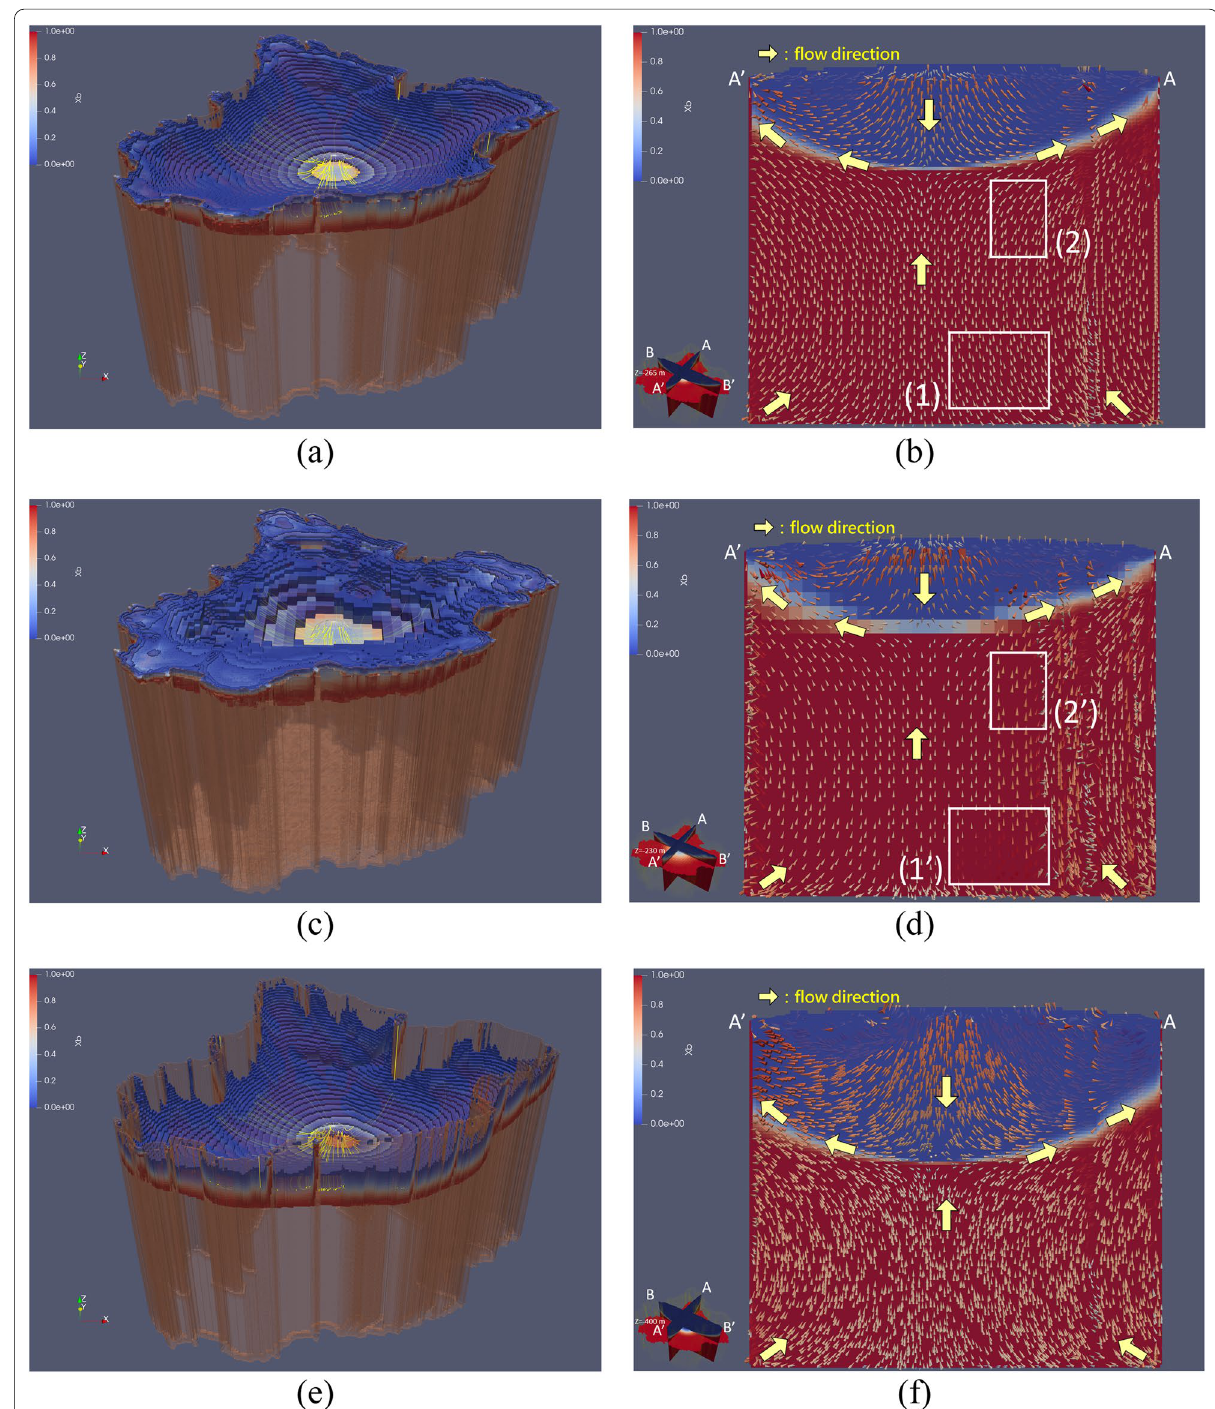
Fig. 10 Groundwater flow and particle tracking simulation results: a base case with the minimum cell size of 10m and a two‑phase top boundary condition with a fully saturated (100% relative humidity) atmosphere; b variant 1 with the minimum cell size increased to 40m ; and c variant 2 with the single‑phase fresh water at the top